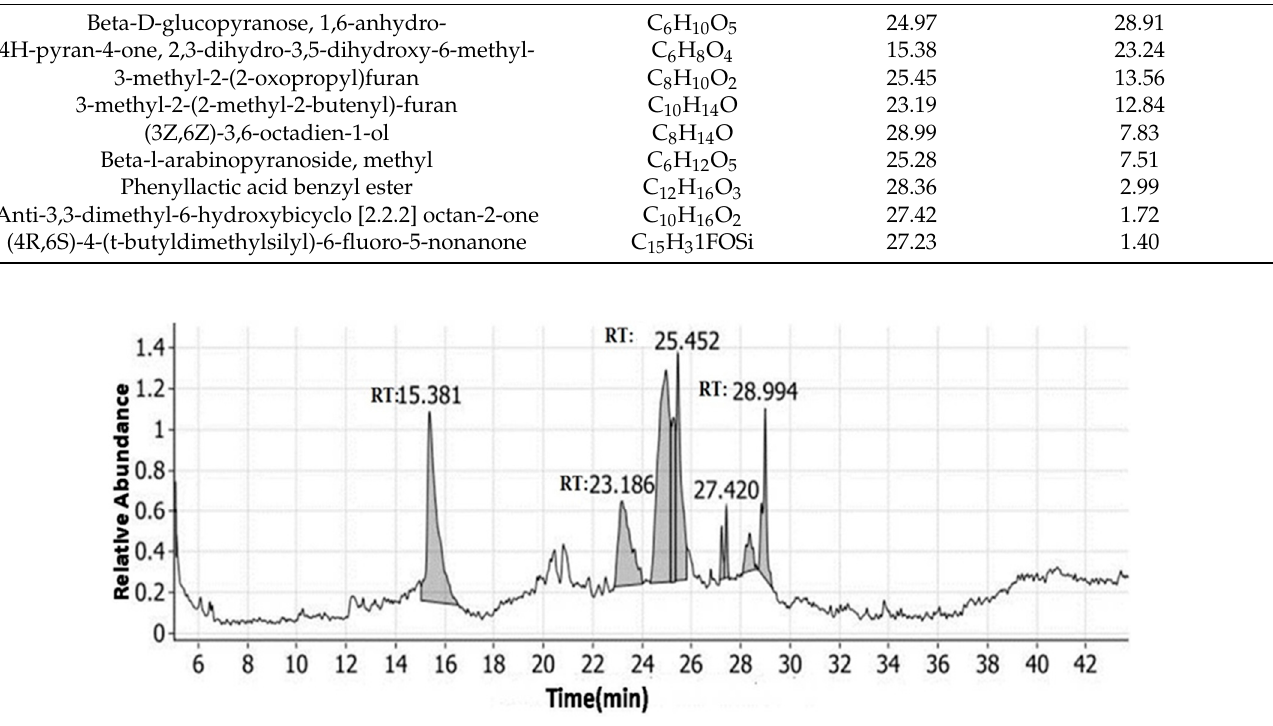
Figure 1. GC-MS chromatogram of A. maurorum ethanolic extract.